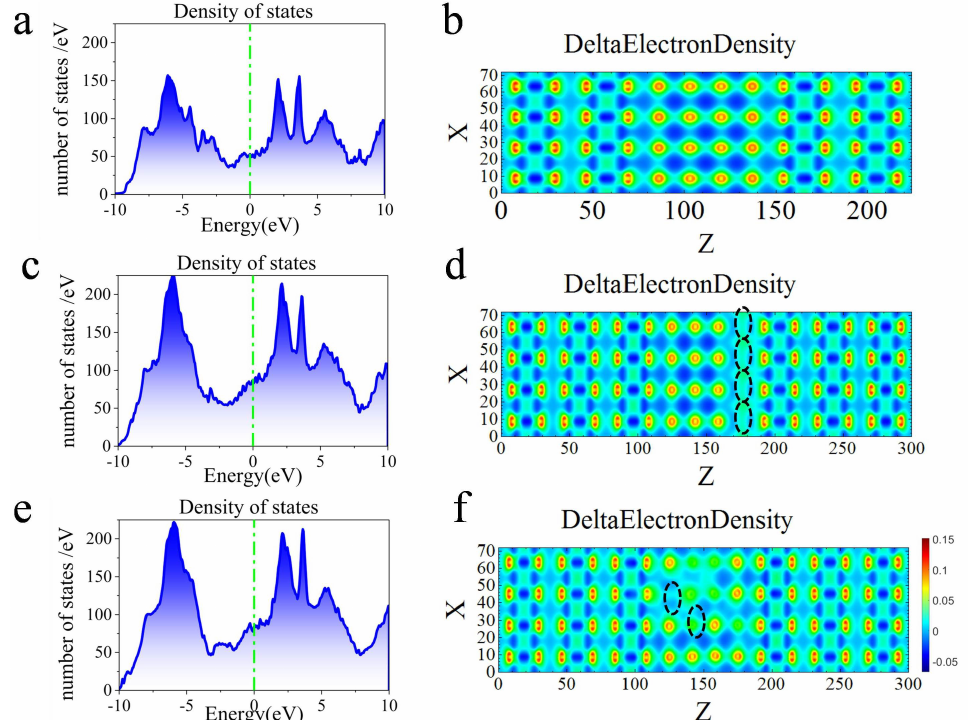
Figure 4. Comparison of the total density of states and delta electron density between typical vacancies model and defect-free model. ( a , c , e ) total density of states of model 3, 3b, 3d, respectively; ( b , d , f ) delta electron density of model 3, 3b, and 3d, respectively. The black dotted circle is the position of N vacancies in the